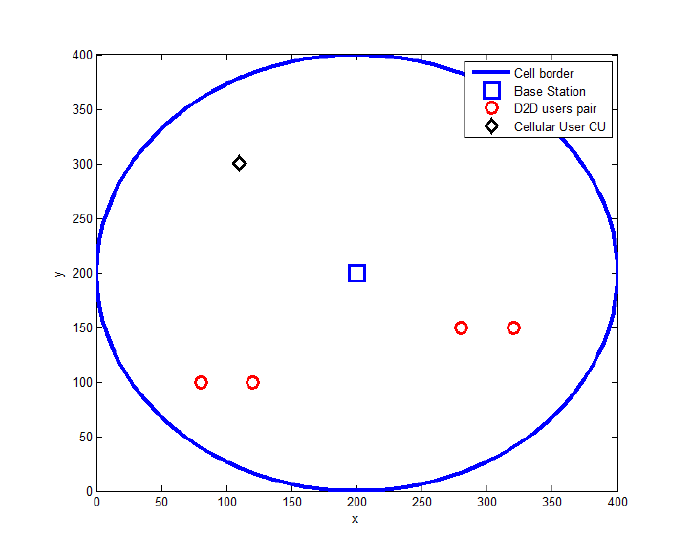
Figure 1. System model of Device-to-Device (D2D) system with uplink resource